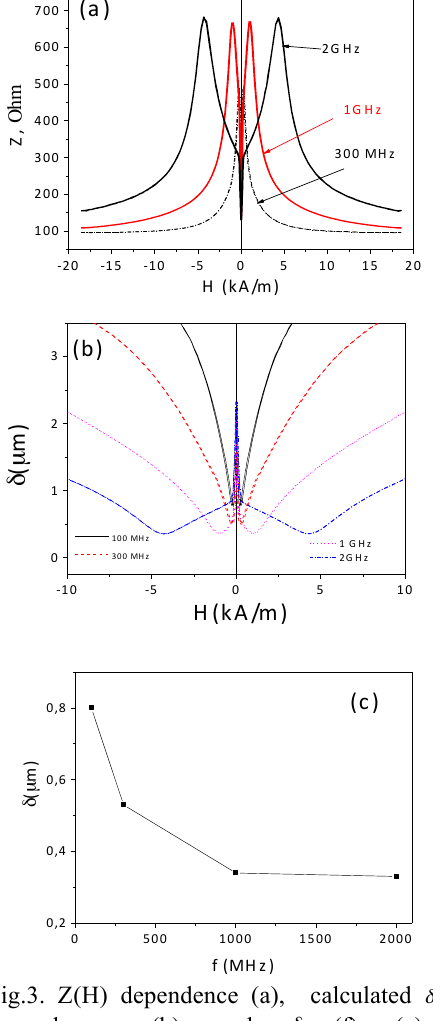
Fig.3. Z(H) dependence (a), calculated δ (H) dependences (b) and δ (f) (c) of min Co Fe Ni Si B Mo C 67.71 4.28 1.57 11.24 12.4 1.25 1.55 microwires ( d =10 µm, D =13.8 µm) at different frequencies